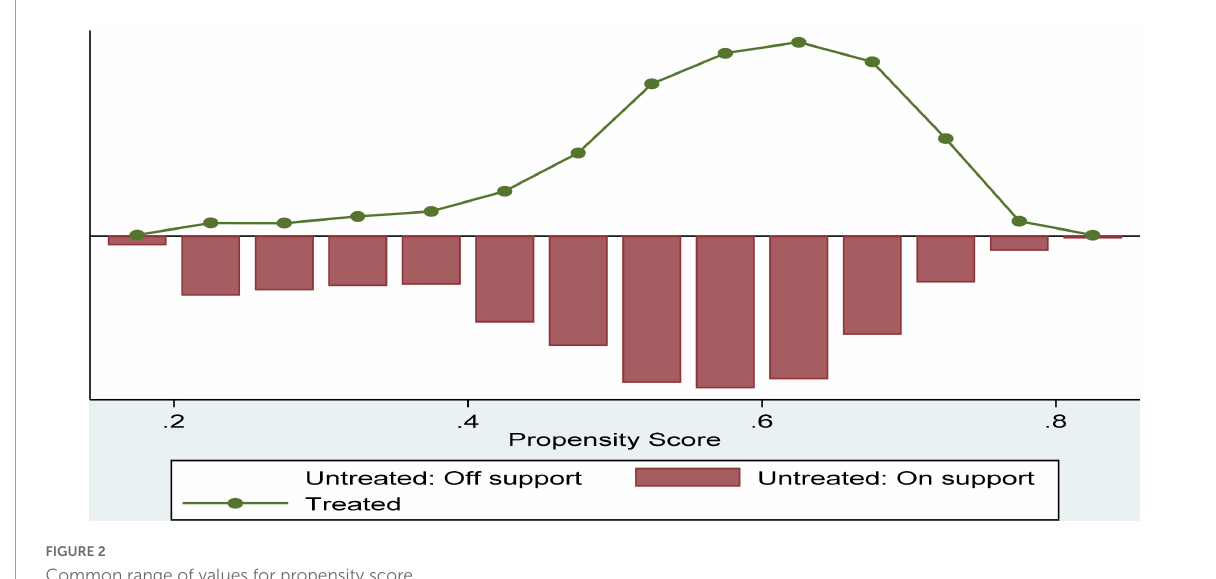
FIGURE2 Common range of values for propensity score.